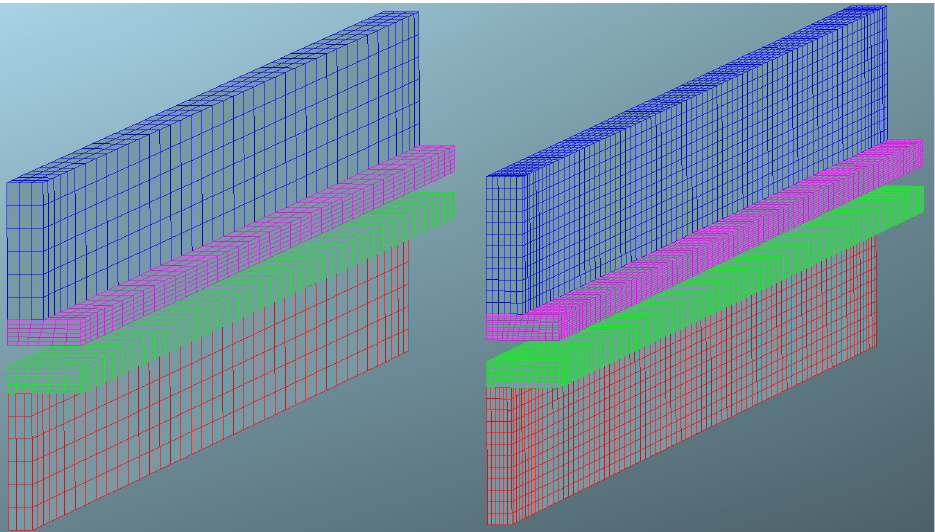
Figure 5. CFD simulation mesh of representative unit as presented in Figure 1. Left is the coarser mesh, right the denser. Volume elements of cathode channel are coloured blue, cathode GDL magenta, anode GDL green and the anode channel red. The same symmetry boundary conditions as presented in Figure 1 apply also to CFD simulation